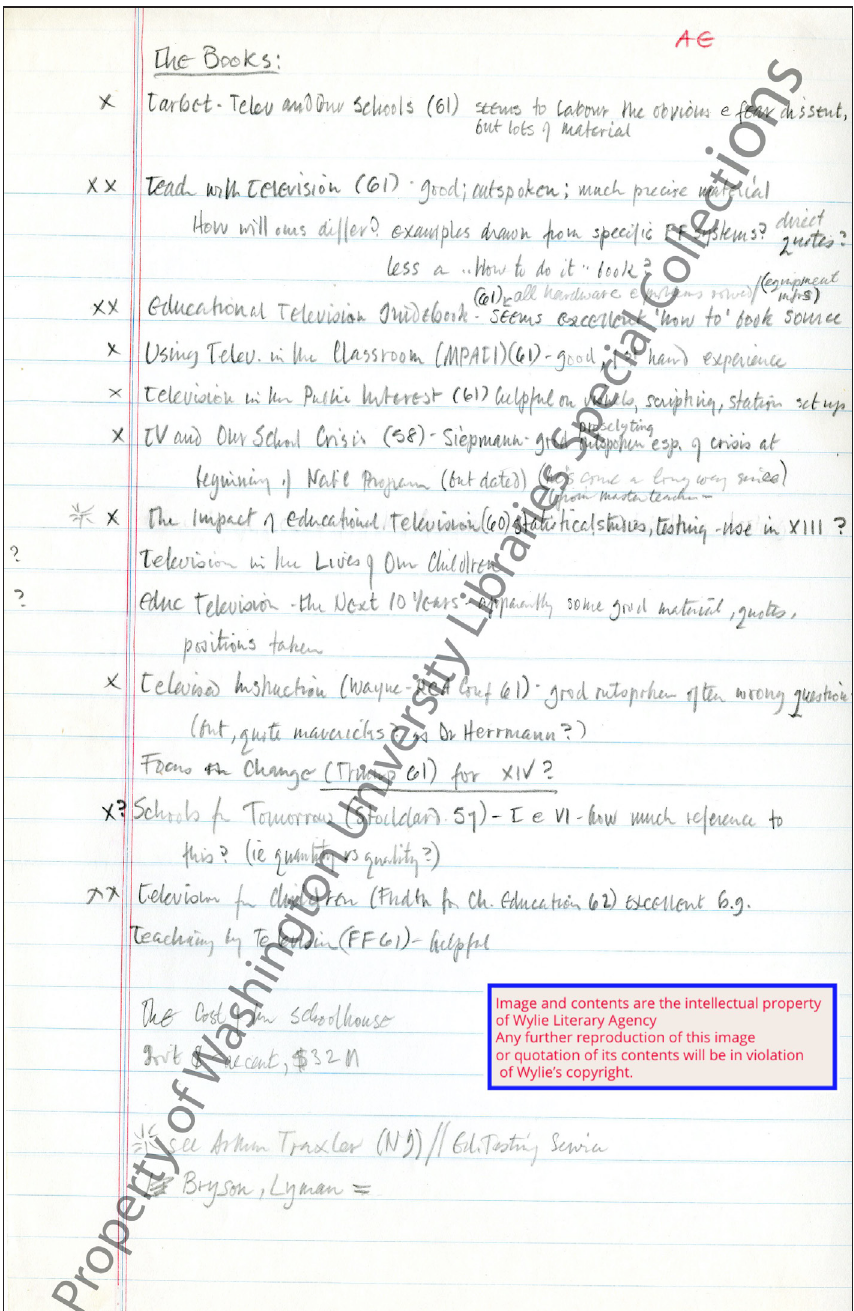
Figure 3: Gaddis’ List of Books Consulted for the Ford